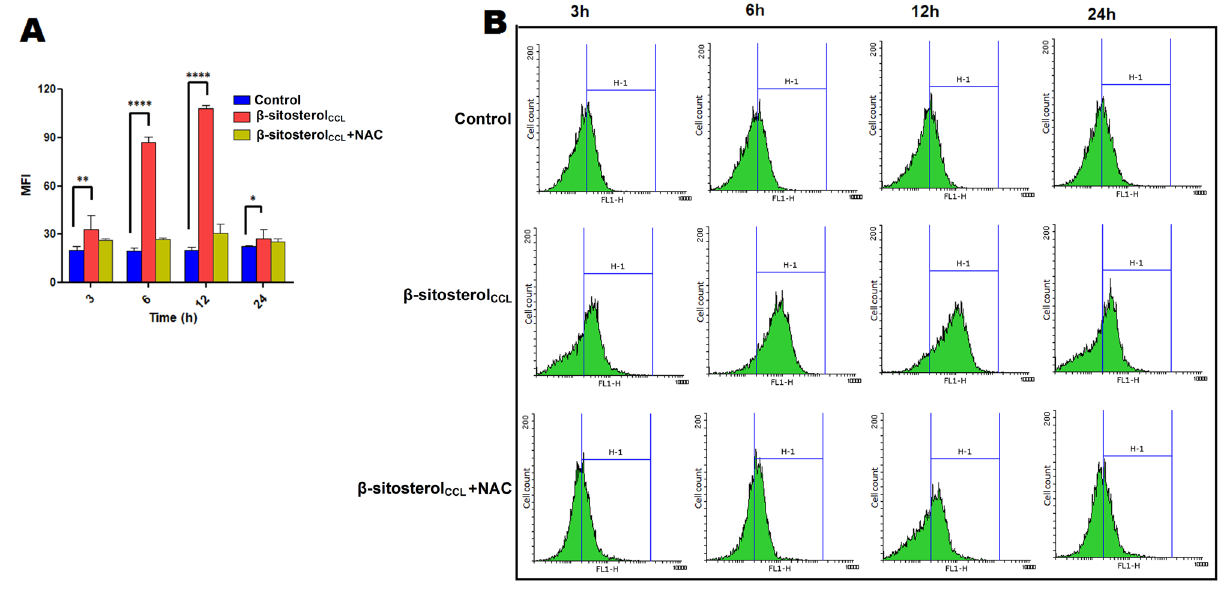
Figure 4. Measurement of intracellular ROS generation in L. donovani promastigotes. ROS generation was monitored by flow cytometry using H 2 DCFDA at 3 h, 6 h, 12 h and 24 h. Elevated ROS level in β-sitosterol CCL - treated parasites was observed compared to the control, whereas ROS generation in NAC-pre-treated promastigotes was found to be restrained to the level in control cells at each time point. Comparison of ROS generation in untreated, β-sitosterol CCL (IC 50 dose)-treated and NAC (20 mM)-pre-treated promastigotes at different time points are represented in both the bar graph and histogram. ( A ) The bar graph is representative of three independent experiments, and statistical significance is calculated compared to the untreated control set by using one-way ANOVA with Dunnett’s multiple comparison test, where * p < 0.05, ** p < 0.01 and **** p < 0.0001 are considered statistically significant. ( B ) Histograms depict the shift of MFI as indicated by the H-1 region. Data were acquired in a BD FACSCalibur flow cytometer and analysed in Flowing software (https :// www.flowi ngsoft ware .com), version 2.5.1, Finland.